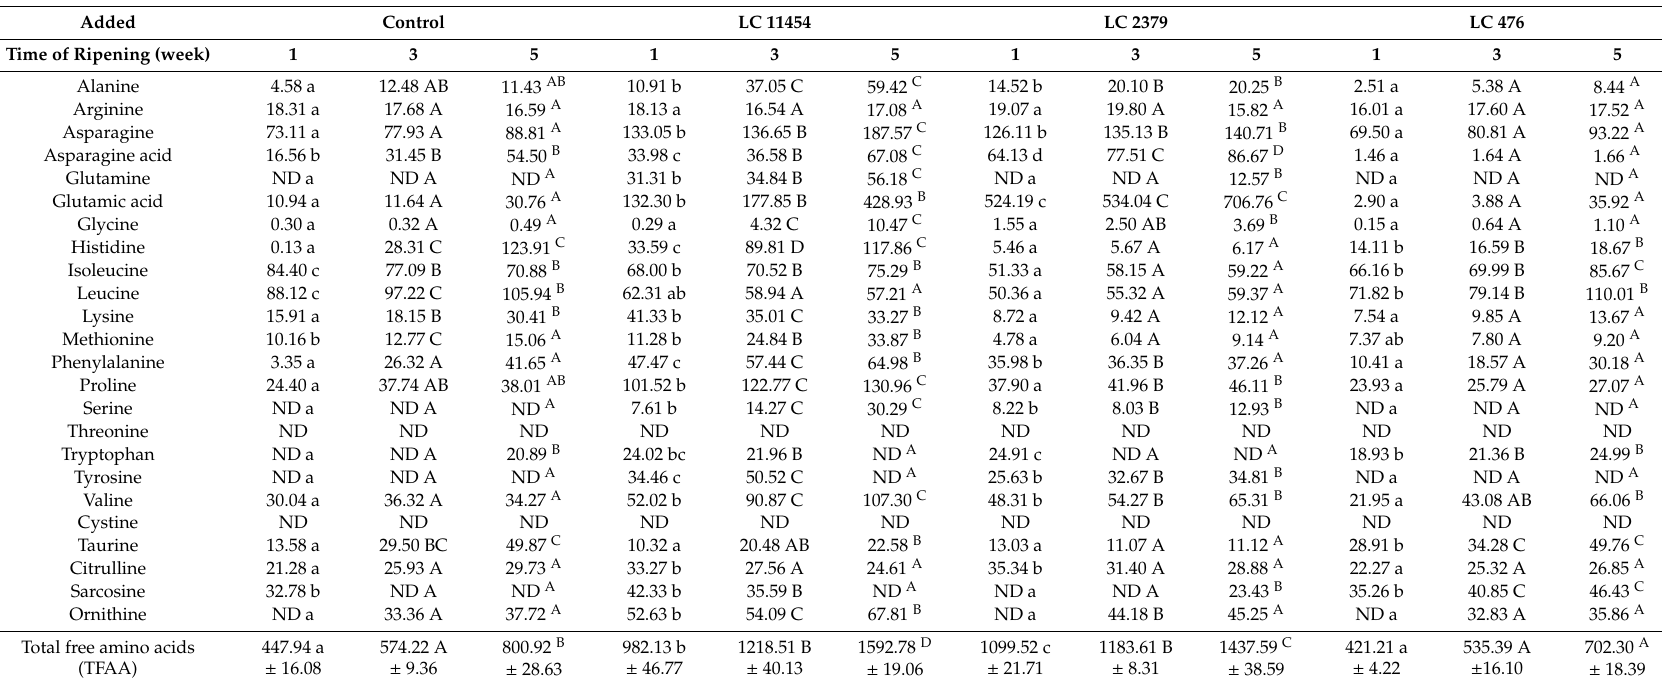
Table 4. Concentrations of individual and total free amino acids (TFAA) in Dutch-type cheese models during ripening (mg · kg − 1